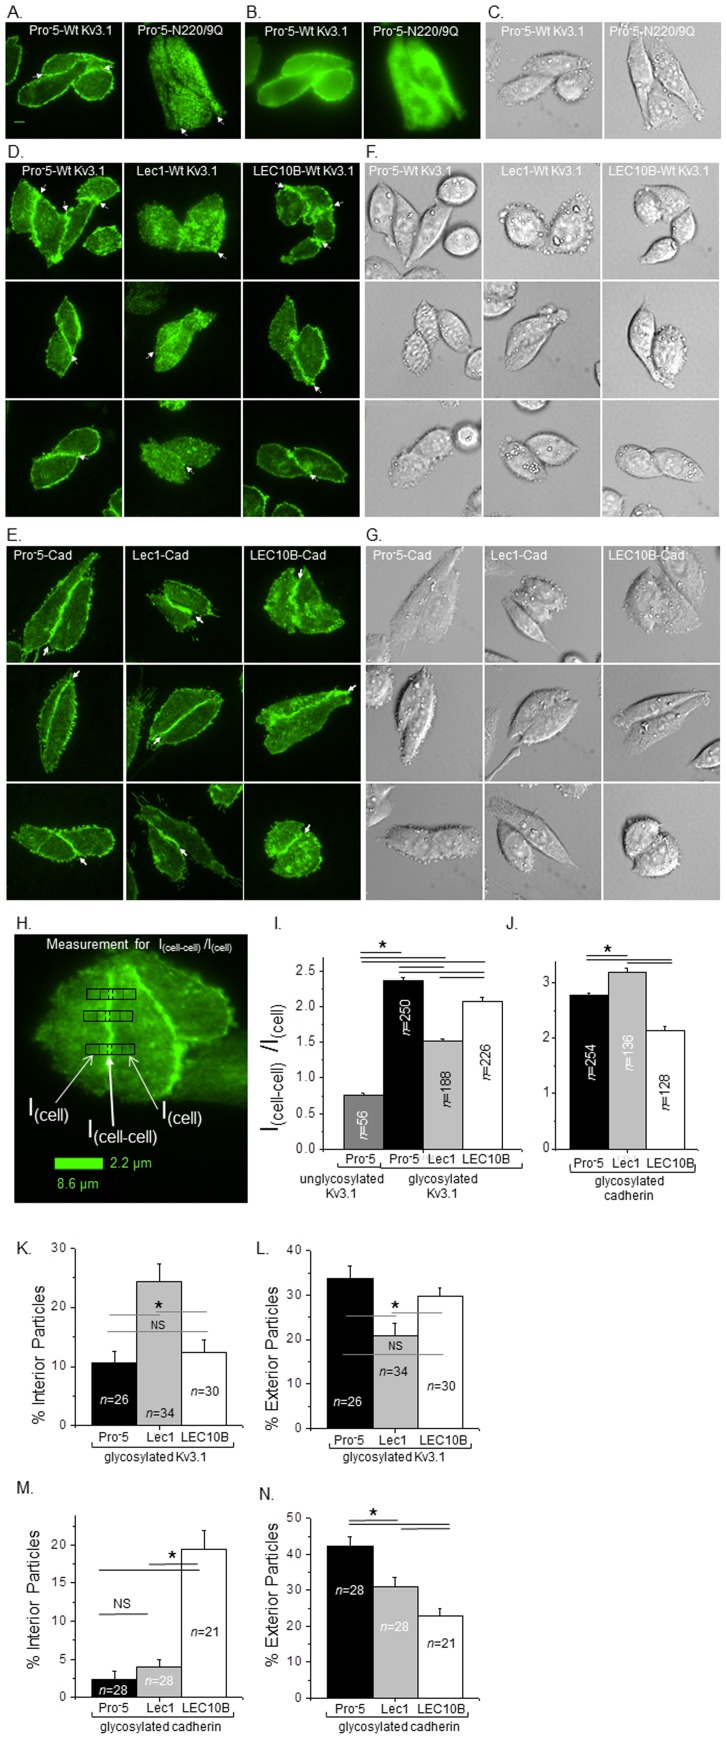
Variations in the glycosylation pathway impact the localization of Kv3.1 and E-cadherin at the cell-cell border.Microscopy images were acquired in TIRF (A), wide-field (B), and DIC (C) modes for EGFP tagged wild type (left panels) and N220Q/N229Q (right panels) Kv3.1 proteins expressed in Pro-5 cells. TIRF (D,E) and DIC (F,G) images of the wild type Kv3.1 (D,F) and E-cadherin (E,G) proteins expressed in Pro-5 (left panels), Lec1 (middle panels), and LEC10B (right panels) cells. Representative scale bar (5 µM) was identical for all images. White arrows point to cell-cell interface. The enlarged TIRF image illustrates the measurements for determining the amount of Kv3.1 and E-cadherin at the cell-cell interface (H). Fluorescence intensity measurements were determined at the cell-cell interface (Icell-cell), and away from the cell-cell interface (Icell) of the cell membrane patch. White arrows point to designated regions in the black rectangle with four dividing lines. The scale bar represents the size of the black rectangles. The bar graph reports the Icell-cell/Icell of N220Q/N229Q (unglycosylated) and wild type (glycosylated) Kv3.1 proteins (I), as well as E-cadherin (J), expressed in the various CHO cell lines. At the 0.000001 level, the differences of the population means are significantly different by one-way ANOVA with Bonferroni adjustment (*). The percent of particles located in the interior (K,M), excluding the particles at the cell-cell interface, and exterior (L,N) regions of the membrane patch was calculated for two interacting cells. At the 0.02 and 0.03 level, the differences of the population means are significantly different by student t-test (*) for the Kv3.1 and E-cadherin proteins, respectively. NS denotes samples are not significantly different.